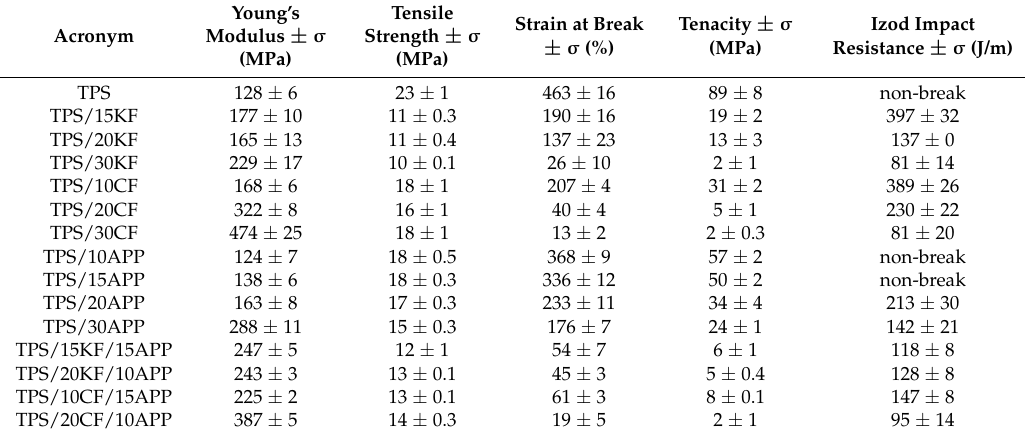
Table 2. Mechanical properties of